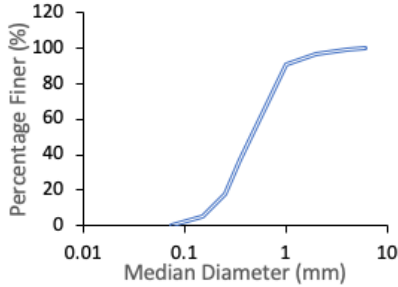
Figure 3. Grain size distribution of bed materials.